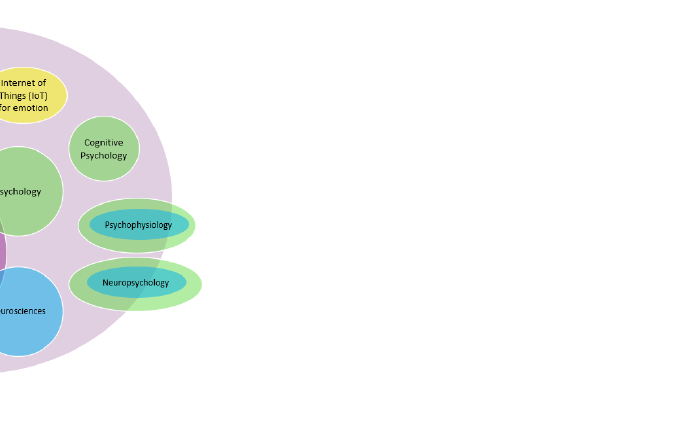
Figure 1. Overview: Integrating emotional knowledge from heterogeneous communities: Artificial Intelligence (e.g., knowledge engineering), Affective Sciences, Internet of Things (IoT), Psychology, Neurosciences, Physiology,